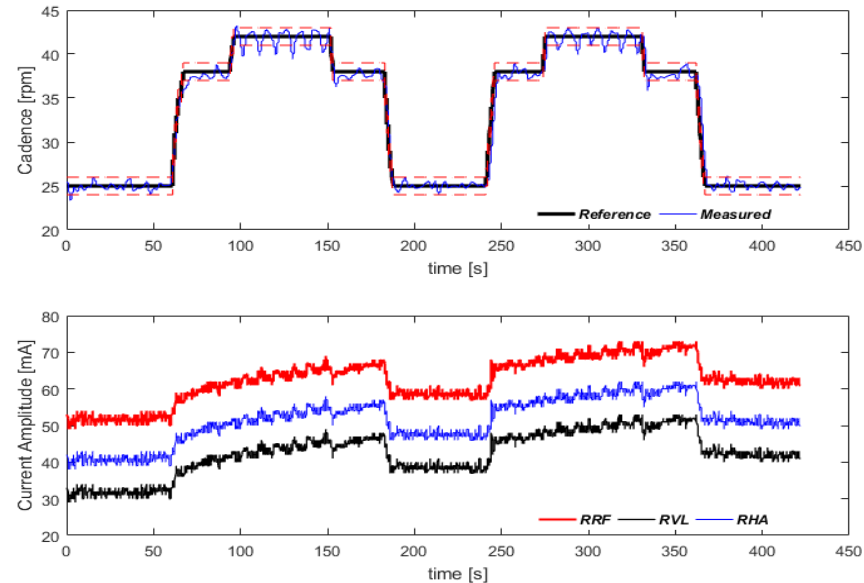
Figure 9. Cadence tracking protocol. In the first graph, the dashed lines around the reference cadence correspond to ±1 rpm. Variation in pulse amplitude for the three muscles of the right lower limb are shown in the second graph. Video for demonstration: https://youtu.be/6cgDhPWPzII (accessed on 21 October 2021).